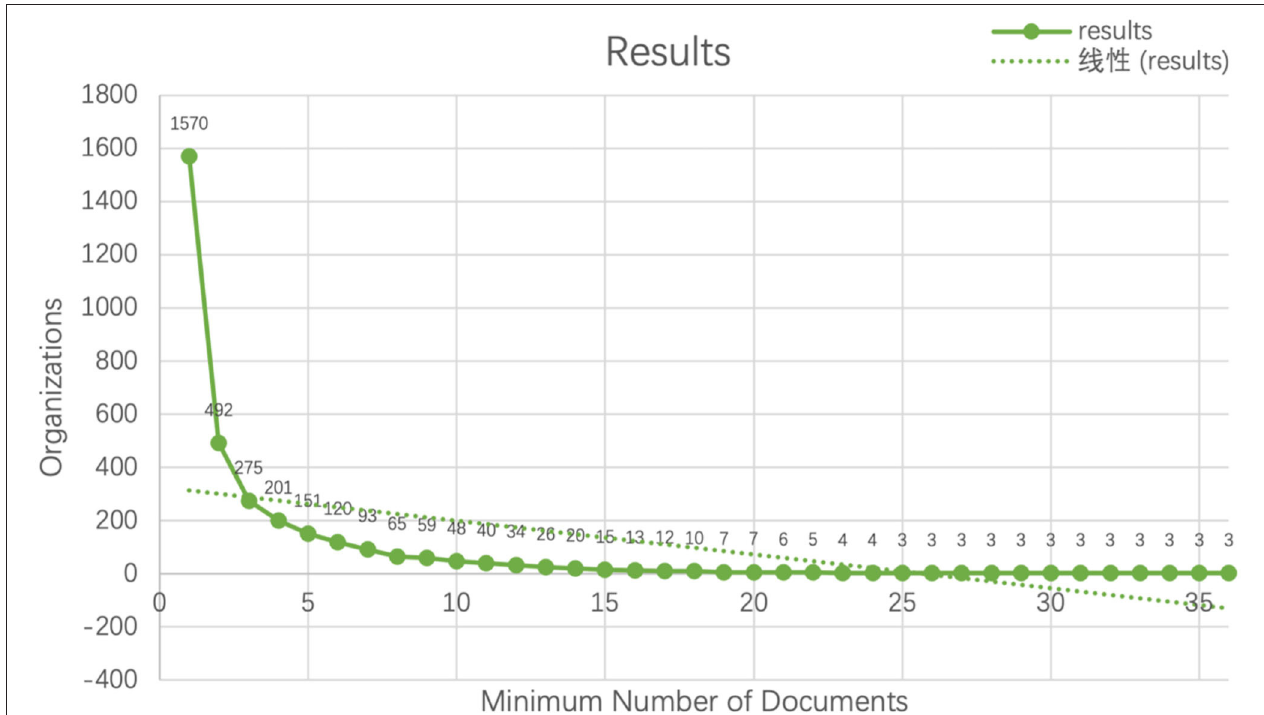
FIGURE 12b | Range of different regions with different thresholds.